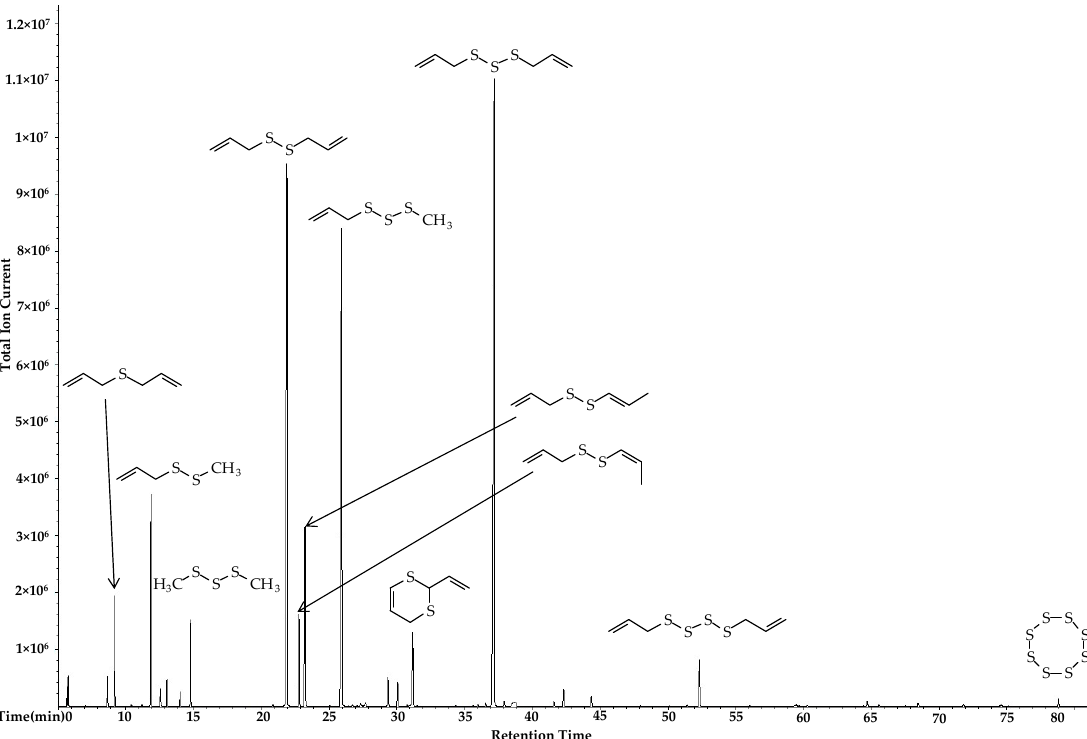
Figure 1. Chromatogram of Allium sativum essential oil from Clevenger distillation, including major sulfur-containing